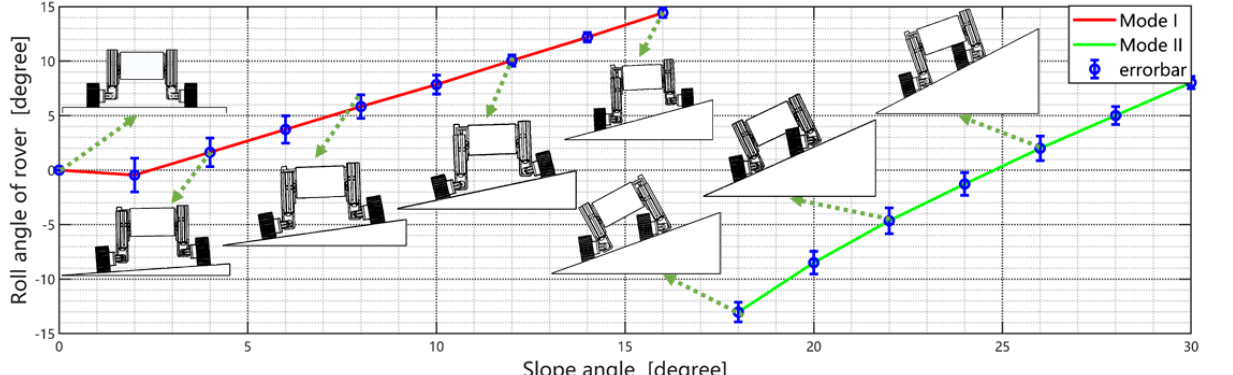
Figure 6. The rover’s optimal configuration and roll angle under different slope angles. The left part (red line) corresponds to Mode I, and the right part (green line) corresponds to Mode II. The slope angle threshold max ( θ b ) between Mode I and Mode II is about 16 ◦